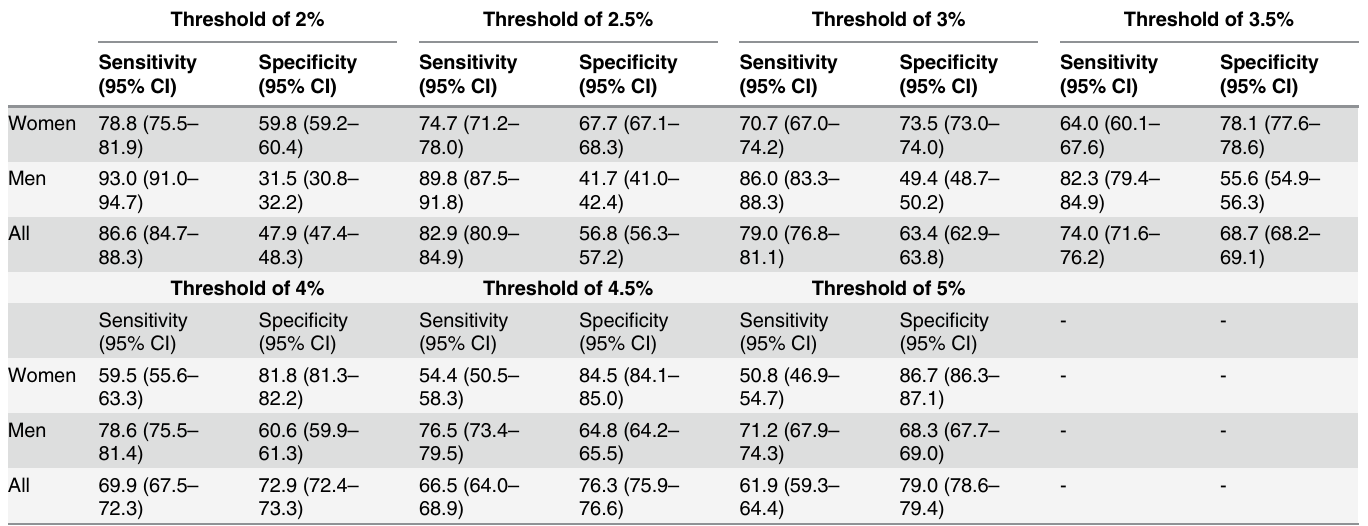
Table 3. The sensitivity and specificity of the model in predicting 10-year risk of CVD deaths in the Golestan Cohort Study participants according to different levels of predicted 10-year risk chose as threshold between low risk and high risk individuals. Threshold of